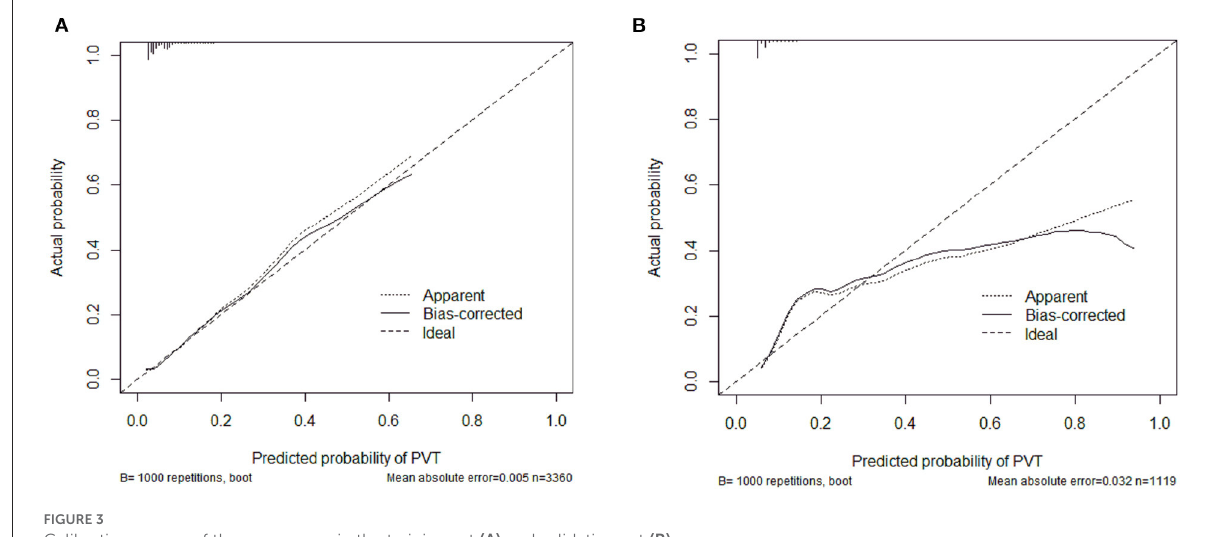
FIGURE3 Calibration curves of the nomogram in the training set (A) and validation set (B) .